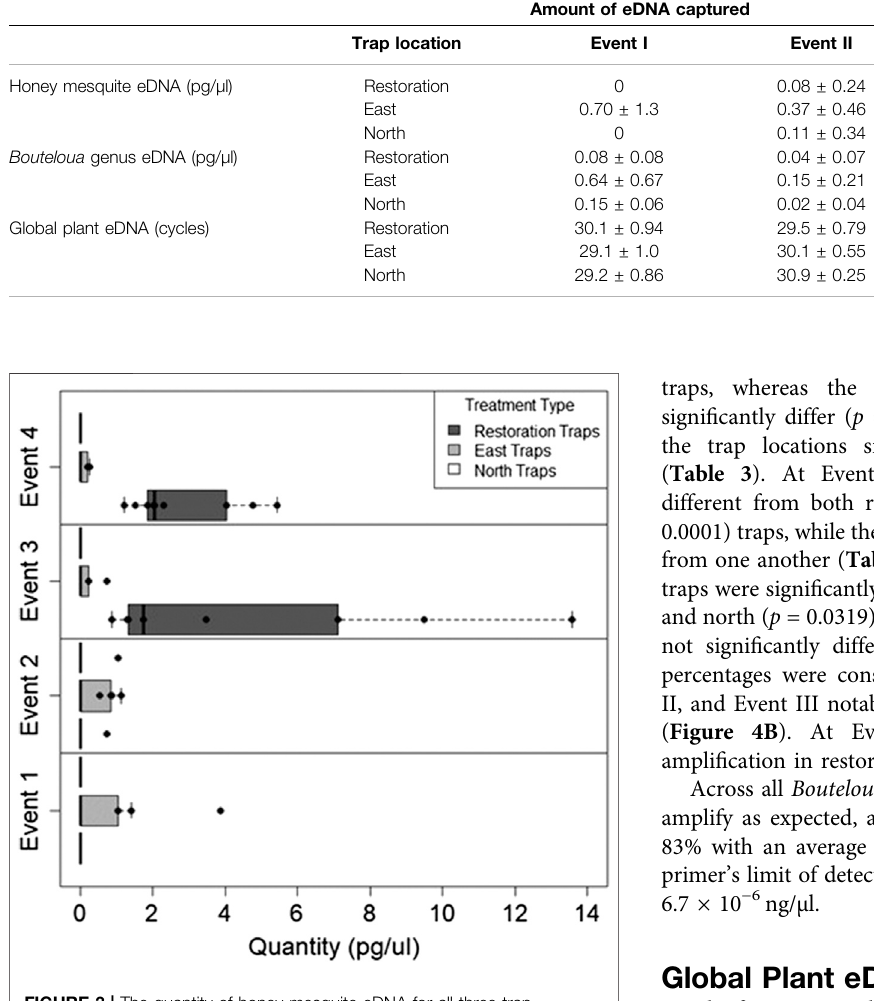
FIGURE 3 | The quantity of honey mesquite eDNA for all three trap locations over four sampling Events. Honey mesquite eDNA increased following restoration activity, especially within the restoration